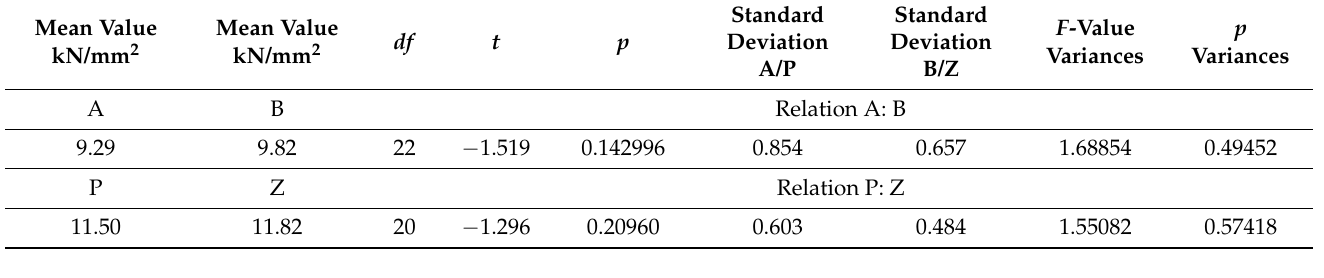
Table 3. Statistical analysis of changes in the modulus of elasticity.